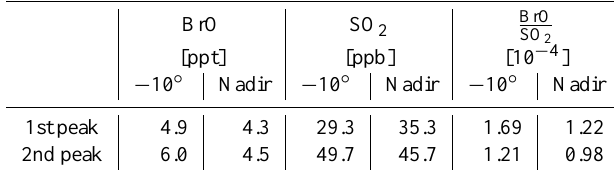
Table 3. Overview of the retrieved BrO and SO 2 mixing ratios based on the CARIBIC DOAS data for the four individual obser- vations of the plume. The variability in the SO 2 data is quite high, which might be caused by the local distribution. Even if the BrO mixing ratio is constant, the error (1.8ppt) is too high to assume that the distribution differs from the SO 2 distribution. BrO SO